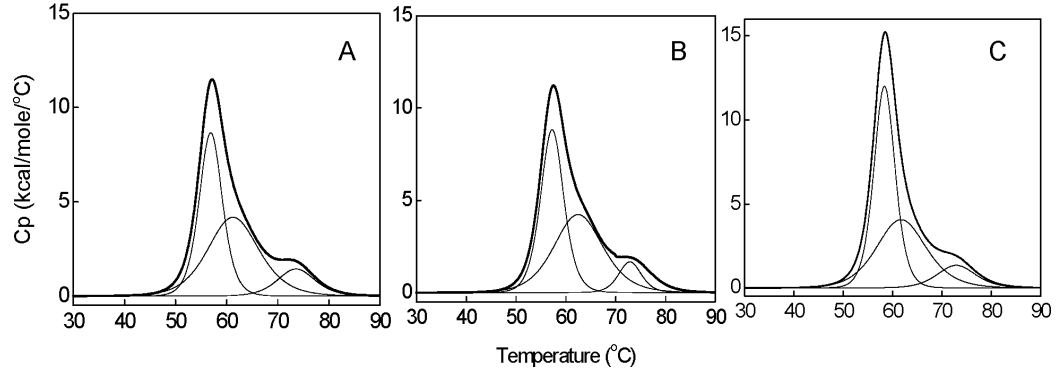
Figure 5. Excess heat capacity curves obtained by differential scanning calorimetry for HSA:HA in the molar ratio of (A) 1:0, (B) 1:5, and (C) 1:10.